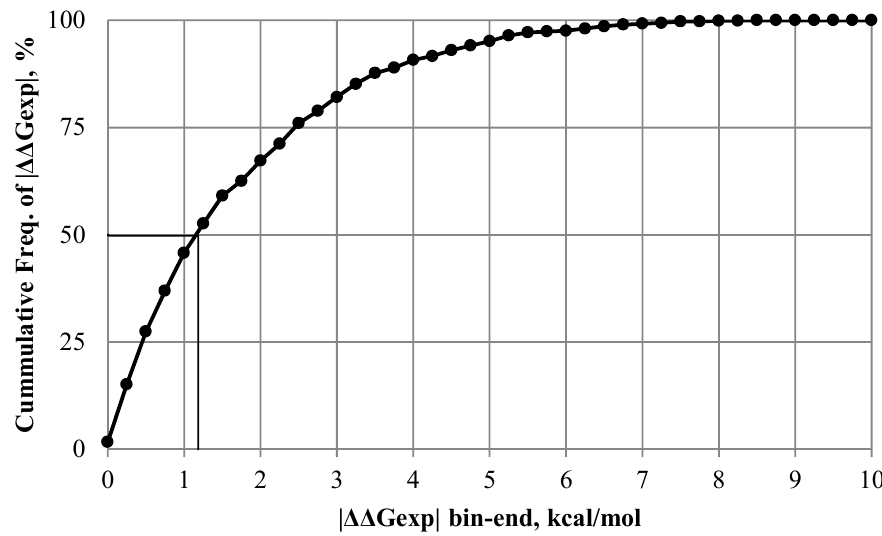
Figure 2. The distribution of the absolute values of the exp G ΔΔ within sDB (statistical dataset).